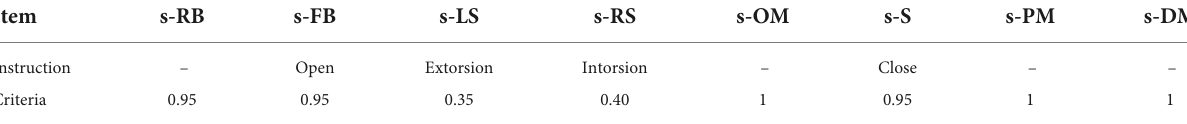
TABLE 17 The operational correspondence and the consistency checking criteria in Task two . Item